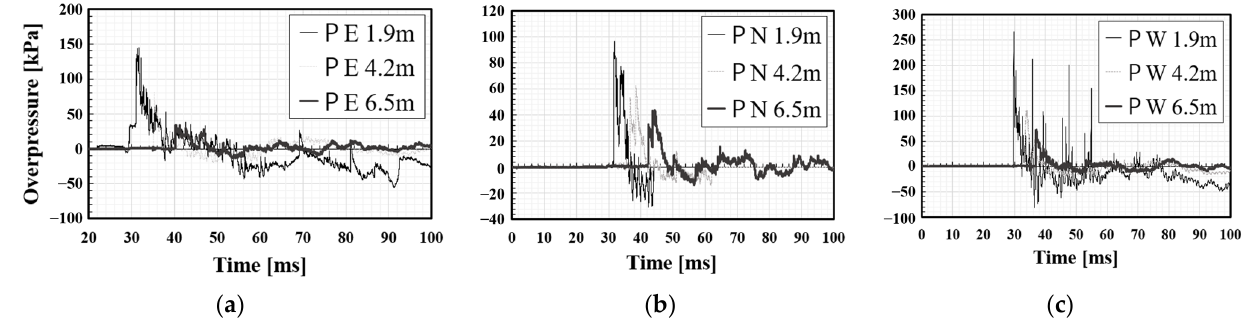
Figure 7. Incident pressures induced by the hydrogen tank explosion: ( a ) east direction; ( b ) north direction; ( c ) west direction. Table 1. Maximum overpressure and impulse at each measurement